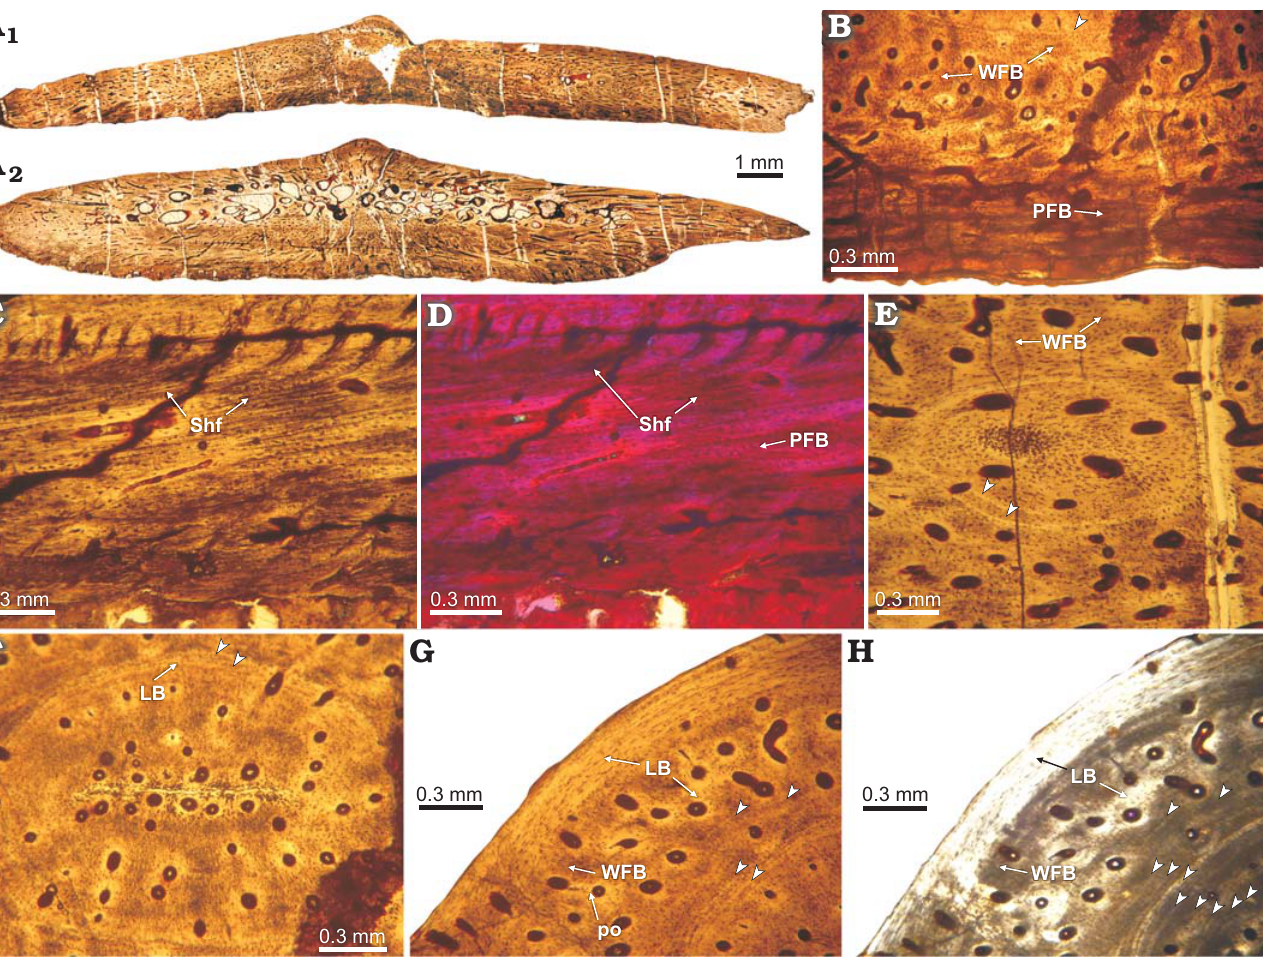
Fig. 5. Histology of osteoderm 2 of doswelliid Vancleavea campi Long and Murray 1995, GR 138 from Coelophysis Quarry, “Siltstone Member”, Chinle Formation, New Mexico, USA, Early Norian. A . Complete transversal section (2C, A 1 ; 2B, A 2 ). B . Detail of basal cortex, constituted by parallel-fibered bone; showing some lines of arrested growth (LAGs) and fibrolamellar bone toward core region. C , D . Detail of the basal cortex (close to the margins); with multiple Sharpey fibers in the parallel-fibered bone. E . View to the annuli with circular shape, on the lateral portions of the osteoderm, composed by lamellar tissue. F . Detail of the inner core region; showing the presence of a concentric annulus (formed by lamellar tissue) and highly vascularized primary tissue enclosed by the annuli. G , H . Detail of the external cortex on the central (i.e., midline) portion of the osteoderm, whereas the outermost portion consists of lamellar bone, the inner part is formed by fibrolamellar. Note arrowheads pointing to growth marks (annuli). A–C, F, G, normal light; H, cross-polarized light; D, cross-polarized light with lambda compensator. Abbreviations: LB, lamellar bone; PFB, parallel-fibered bone; Shf, Sharpey’s fibers; WFB, woven-fibered